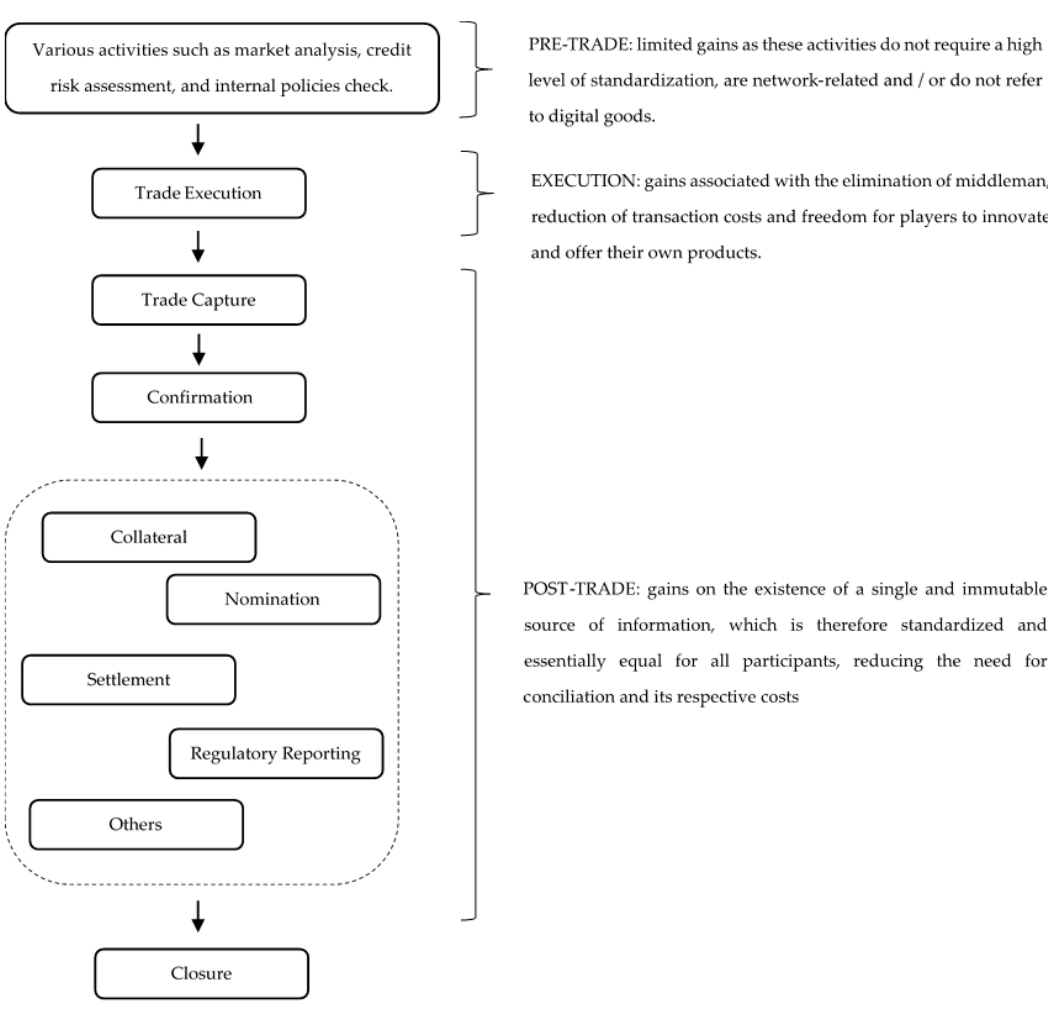
Figure 2. The OTC trade lifecycle and potential benefits from